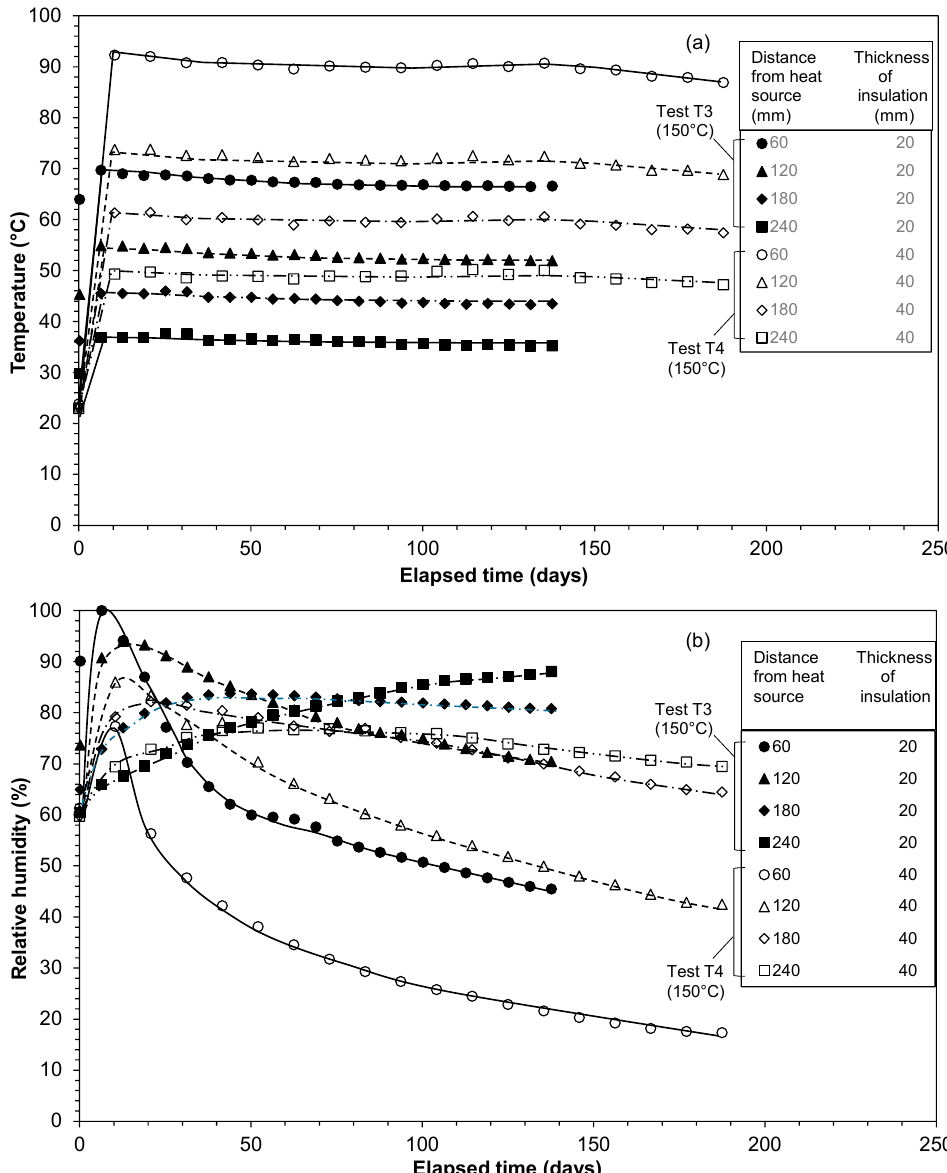
Figure 3. Effects of thermal gradient (150 °C, bottom; and 25 °C, top) on the distributions of: ( a ) temperature; ( b ) relative humidity in compacted bentonite specimens (diameter 100 mm, height 300 mm).